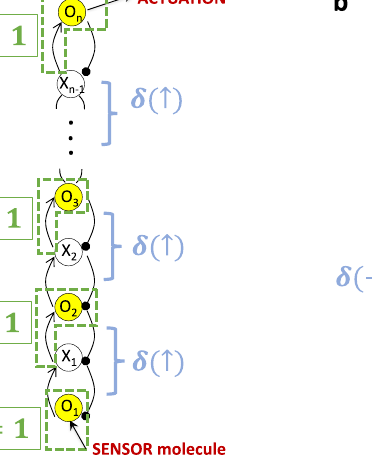
indicated. b A Balancer module, containing multiple feedforward segments between the diverter molecule (D) and the connector molecule (C). A Balancer module with just two (incoherent) feedforward segments, without any embedded feedback loop, has a de fi ciency of one, as shown. Each additional feedforward segmentincreases de fi ciencyby one, asshown. Anyfeedbackloopembeddedinto a feedforward segment also increases de fi ciency by one (not